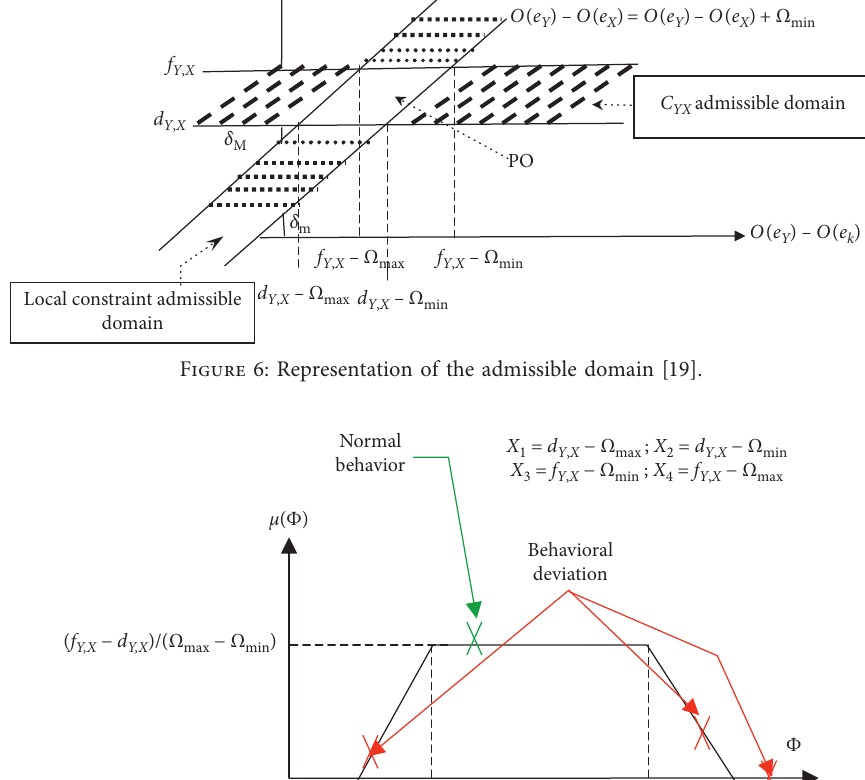
1 ≥ 0, X 2 ≥ 0, X 3 ≥ 0 and X 4 ≥